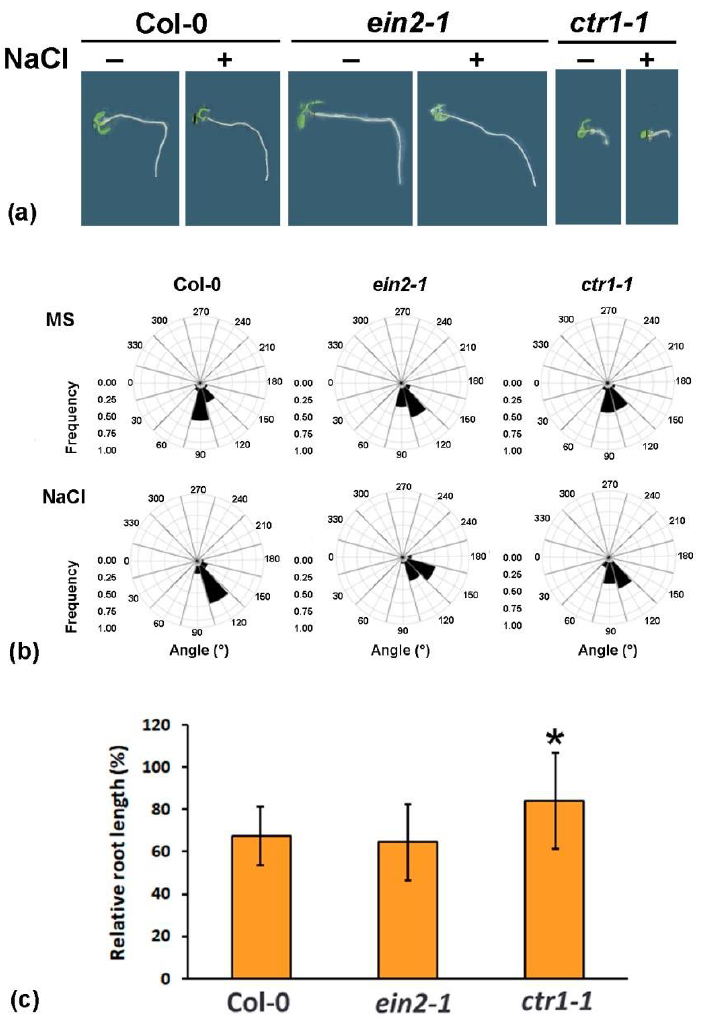
Figure 1. ( a ) Representative images of gravistimulated individuals with Col-0, ein2-1 and ctr1-1 genetic background on half-strength Murashige and Scoog (½ MS) media +/ − 100 mM NaCl. ( b ) Quantification of root gravitropism of seedlings presented in ( a ). Roots were assigned to twelve 30 sectors on a gravitropism diagram. The size of each bar represents the frequency of seedlings showing the particular growth direction. ( c ) Root growth inhibition of the gravistimulated individuals with the wild type Col-0, and ein2-1 and ctr1-1 mutant backgrounds grown on ½ MS media +/ − 100 mM NaCl. Asterisk represents statistically significant difference compared to NaCl-treated wild type (Col-0) (Student’s t -test, * p ≤0.05, n =3 datasets, 20 individuals per experimental group were evaluated in each dataset).